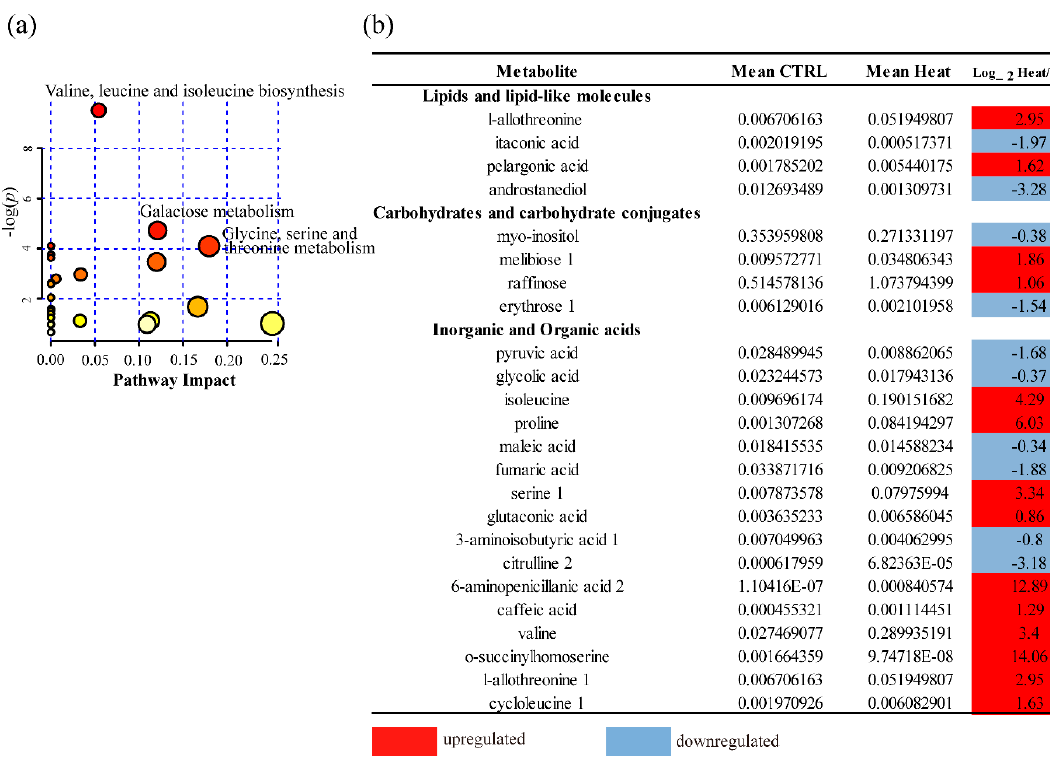
Figure 4. Changes in the expression of genes related to photosynthesis and oxidative phosphorylation under heat stress. ( a ) Pathway diagram of the light reactions of photosynthesis. LHC I/II, light- harvesting complex I/II; PS I/II, photosystem I/II; PQ, plastoquinone; Cyt b6, cytochrome b6f complex; PC, plastocyanin; Chl, chlorophyll; Fdx, ferredoxin. ( b ) Pathway diagram of oxidative phosphorylation. NAD, Nicotinamide adenine dinucleotide; UQ, ubiquinone; Cyt c, cytochrome; ADP, adenosine diphosphate; ATP, adenosine triphosphate. Colors at right indicate the log 2 expression ratio [log 2 (heat/control_ mean)], and at left the fragments per transcript kilobase per million fragments mapped (FPKM) value of the control. (Levels 1–8, FPKM values of 0–10, 10–20, 20–